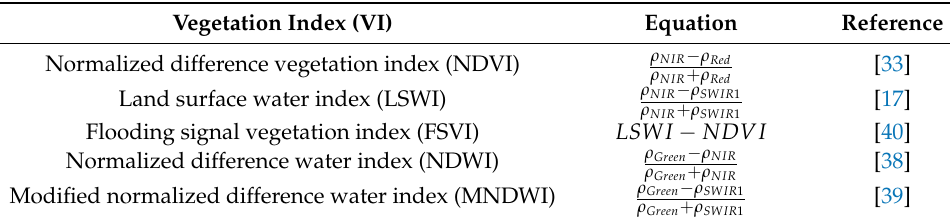
Table 2. Five vegetation indices (VIs) selected in this study and their associated equations. Vegetation Index ( VI )